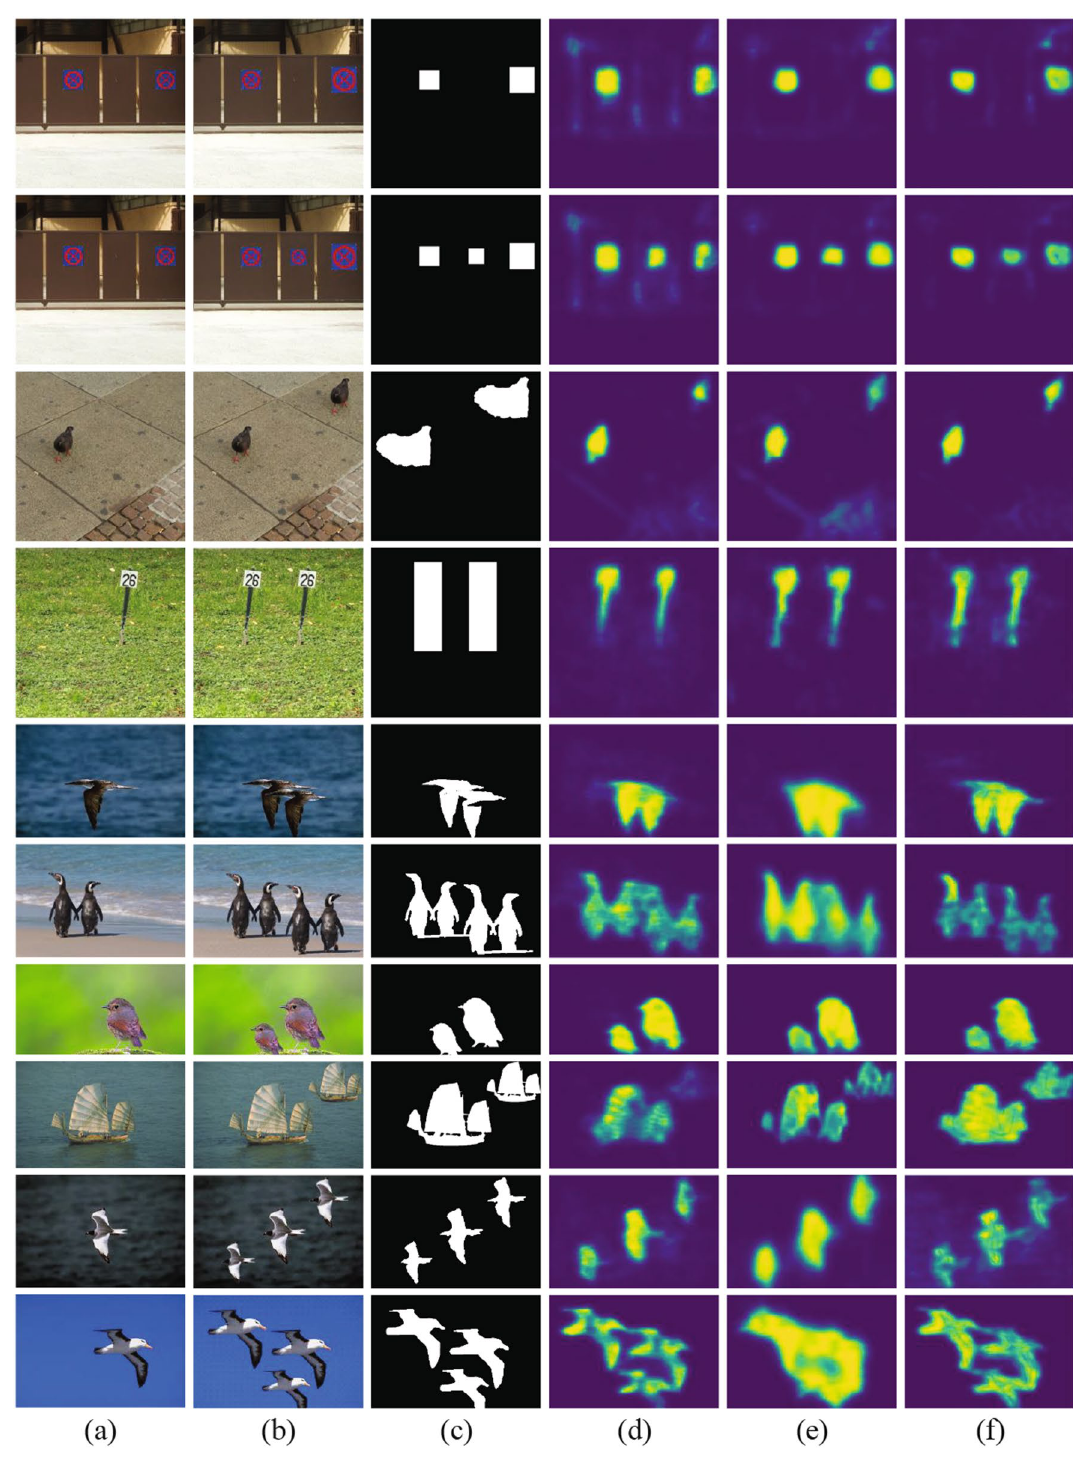
Figure 6. Detection results of the SD-Net on CoMoFoD 30 and CASIA II 33 datasets: ( a ) original images, ( b ) forgery images, ( c ) ground-truth tampered regions, ( d ) detection results of Base-Refine, ( e ) detection results of Base-Segment, and ( f ) detection results of the